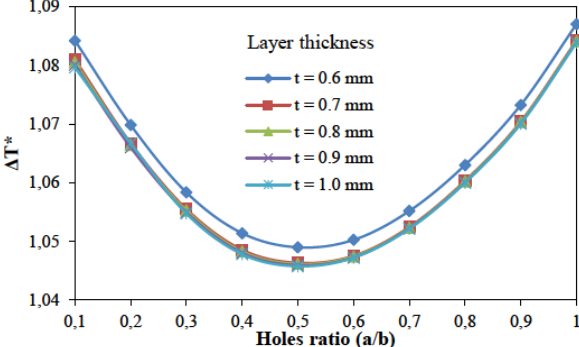
Figure 8: Effect of hole ratio (a/b) on the thermal buckling amplifica- tion factor ( φ = 0 ∘ ).